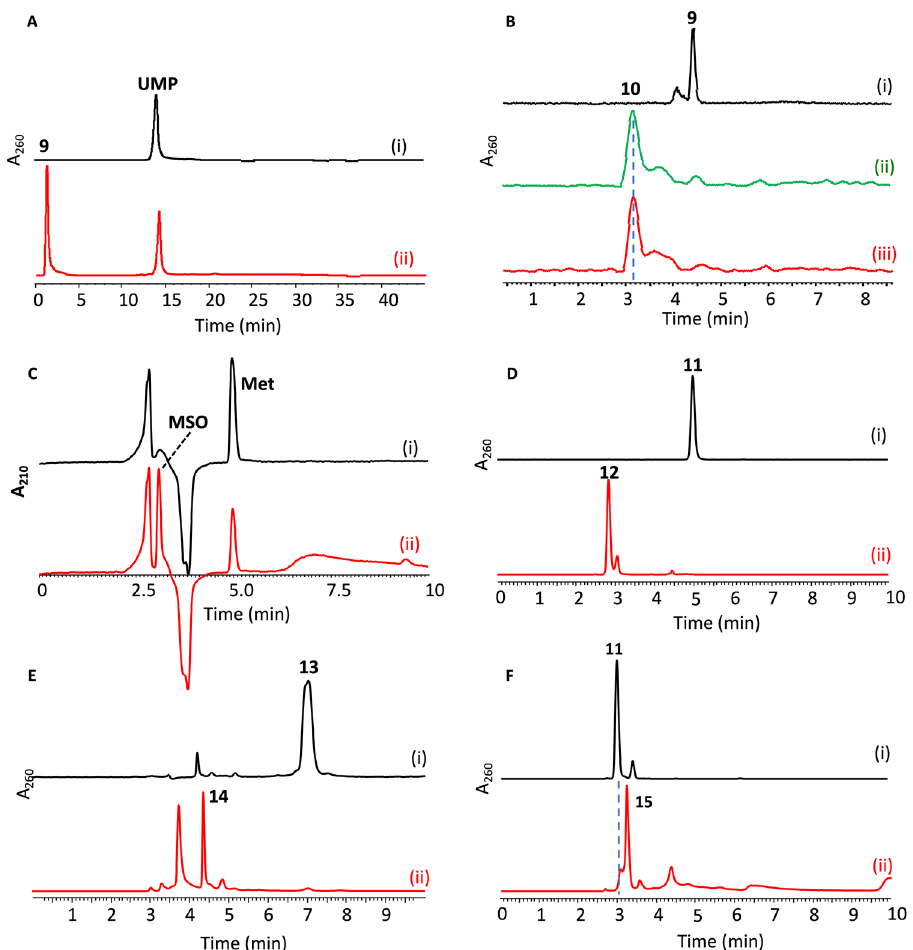
Fig. 3 LC traces for enzymatic reactions catalyzed by enzymes involved in the biosynthesis of nucleoside antibiotics. A Oxidative dephosphorylation reactions catalyzed by Cpz15, in which UMP (i, without Cpz15) is converted to compound 9 (ii, with Cpz15). B Coupling reactions catalyzed by Mur17, in which compound 9 (i, without enzyme) plus either threonine (ii) or glycine (iii) can be converted to compound 10 ; both substrate and product were derivatized with dansyl chloride before subjected to LC analysis. C Oxygenation reactions catalyzed by Cpz10, in which methionine (i, without Cpz10) can be converted to MSO (ii, with Cpz10). D Hydroxylation reactions catalyzed by Cpz10, in which synthetic compound 11 (i, without Cpz10) can be converted to compound 12 (ii, with Cpz10). E Phosphorylation reactions catalyzed by Cpz27, in which collected compound 13 (i, without Cpz27) can be converted to compound 14 in the presence of ATP (ii, with Cpz27). F . Decarboxylation reactions catalyzed by Mur23, in which compound 11 (i, without Mur23) can be converted to compound 15 (ii, with Mur23); both substrate and product were derivatized with dansyl chloride before subjected to LC